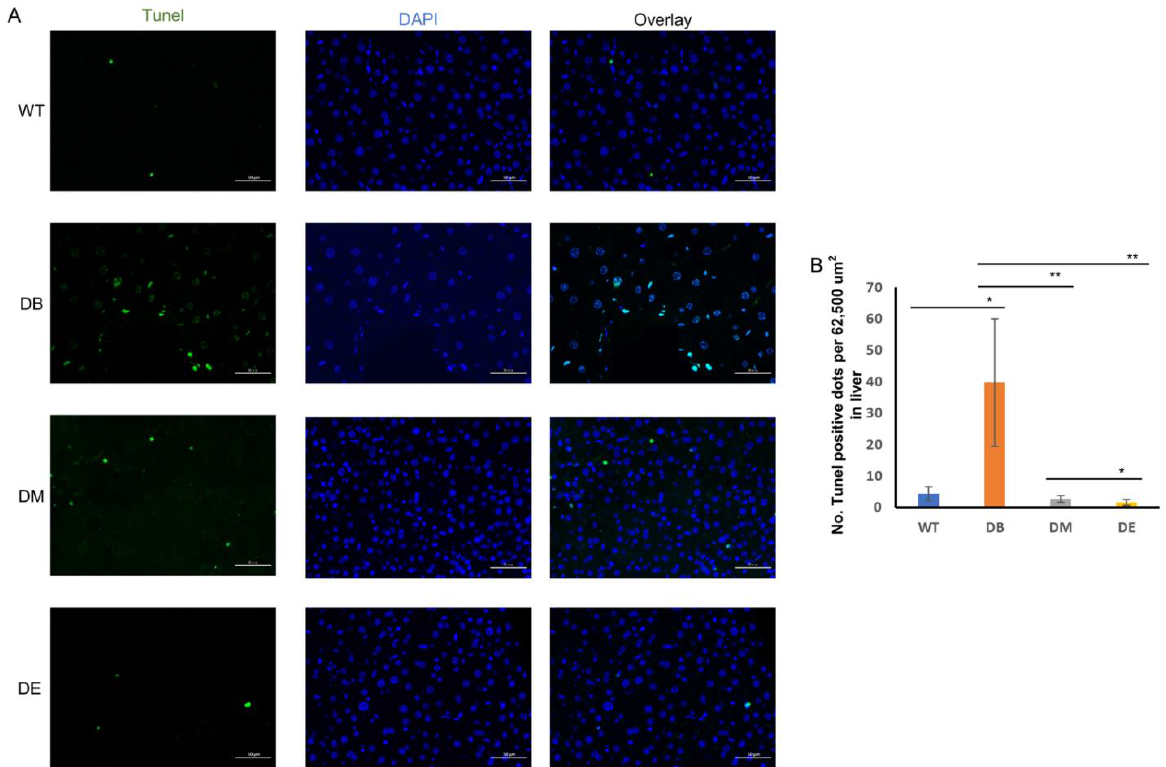
Figure 7. Night exercise is better than morning exercise in relieving apoptosis caused by diabetes. ( A ) Representative images of Tunel in livers from WT, DB, DM, and DE mice. ( B ) Statistical evaluation of Tunel signal in livers from WT, DB, DM, and DE mice. * p < 0.05 and ** p < 0.01, n = 3. Scale bar: 50 µ